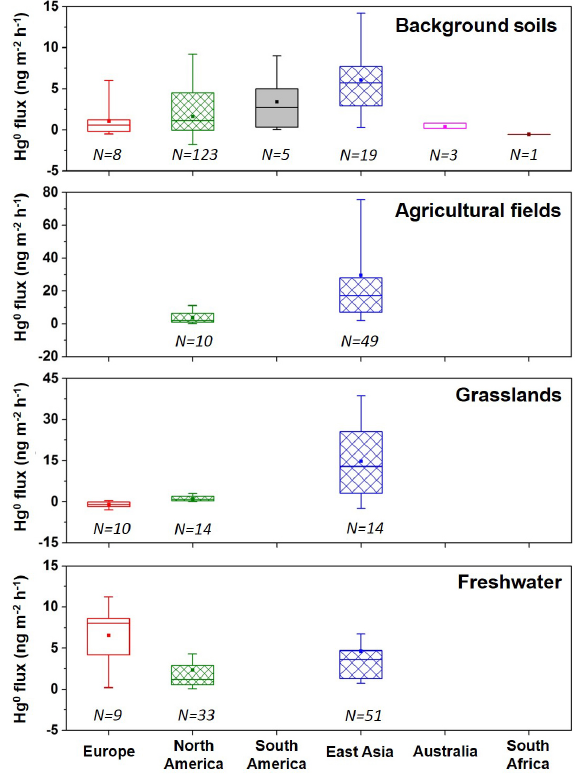
Figure 8. Box and whisker plots of continents segregated Hg 0 flux obtained from four homogeneous surfaces (Background soils, agri- cultural fields, grasslands and freshwater. Filled square block and horizontal line in box indicate mean and median flux).